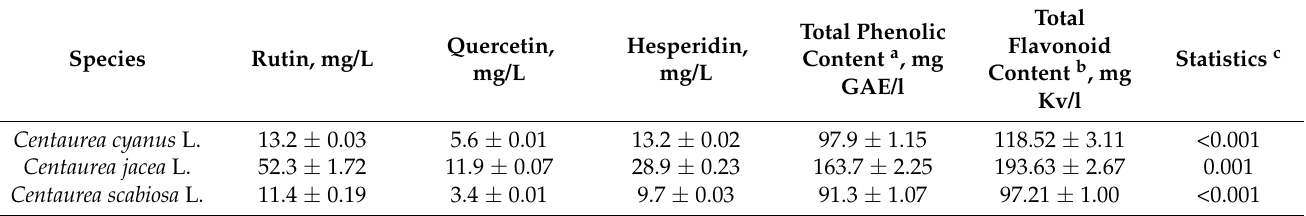
Total Total Phenolic Flavonoid Quercetin, Hesperidin, Statistics c Content a , mg Content b , mg mg/L mg/L GAE/l Kv/l